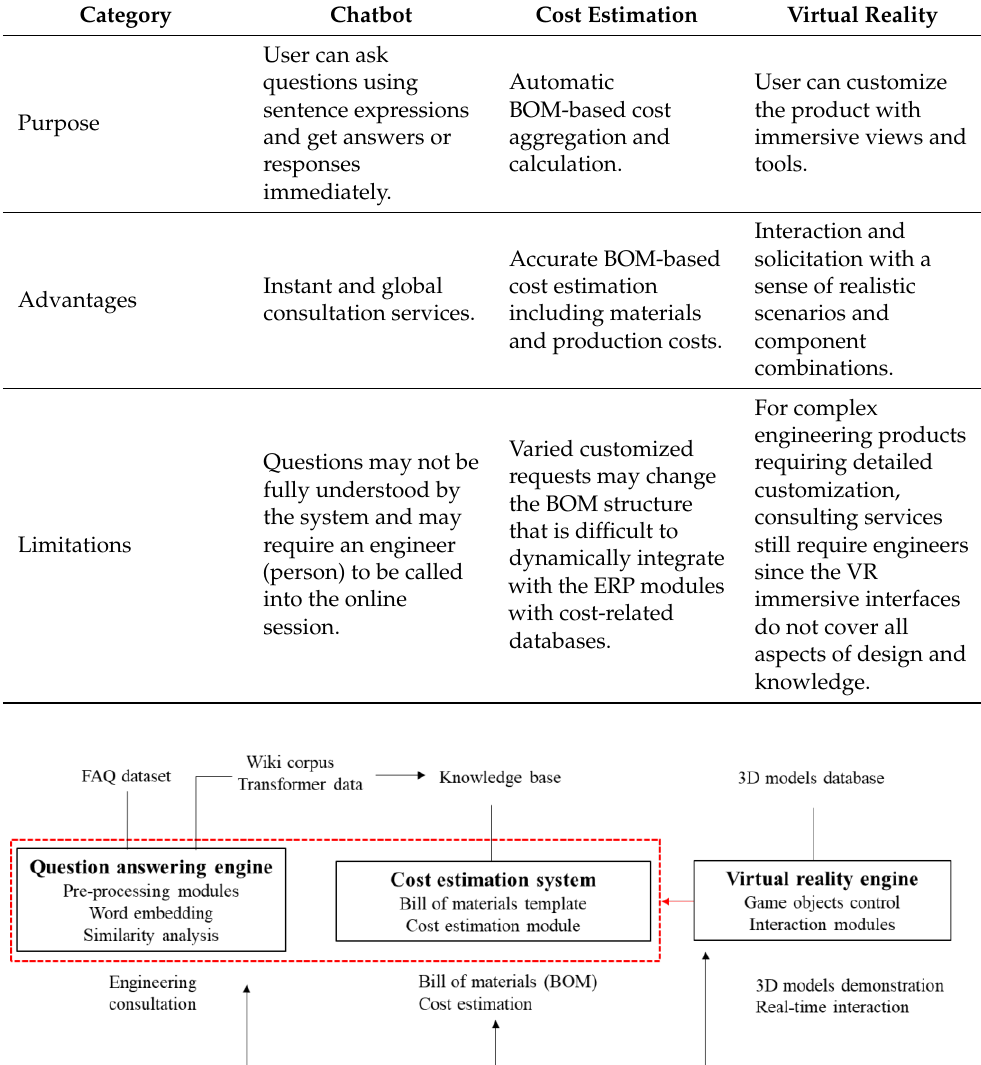
Table 2. Research challenges of the proposed chatbot for complex and highly customized engineering products.